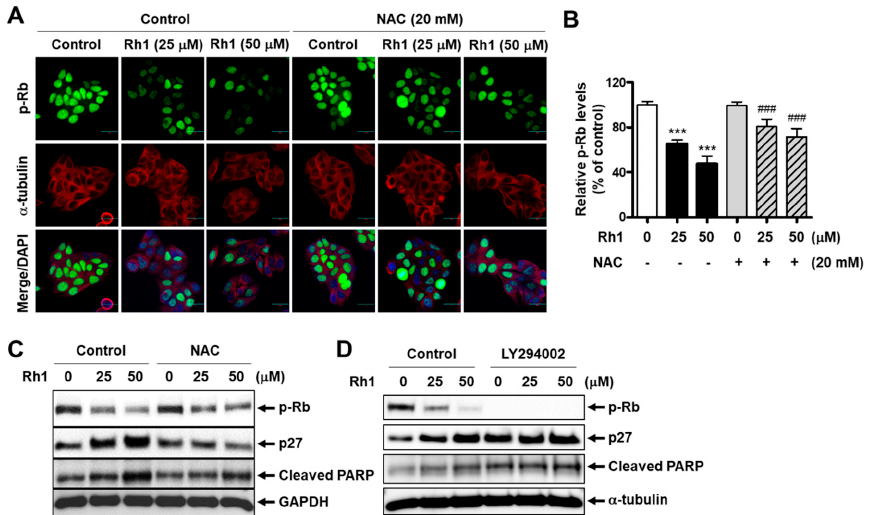
Figure 4. Cell cycle arrest and apoptosis induced by Rh1 is associated with the ROS-mediated Akt pathway in MCF-7 cells. ( A , B ) The cells were pretreated with NAC (20 mM) for 3 h, followed by the treatment with Rh1 for 24 h. An immunofluorescence analysis was performed after fixing and immunostaining. Images ( A ) are shown at ×200 magnification. Scale bar indicates 30 µm. The relative expression of phosphorylated Rb ( B ) represents the mean ± SD ( n = 6 ), ** * p < 0.001 compared with the control sample and ### p < 0.001 compared with the Rh1-treated sample, respectively. ( C , D ) The cells were pretreated with 20-mM NAC ( C ) or 5-µM LY294002 ( D ) for 3 h, followed by the treatment with Rh1 for 24 h. Total cell lysates were subjected to Western blotting. NAC: N-acetylcysteine and LY294002: PI3K inhibitor.